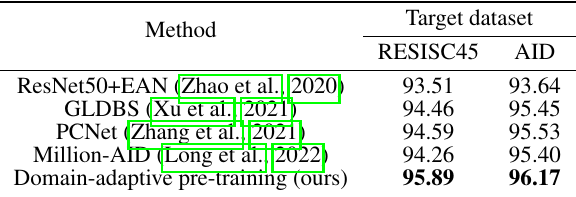
Table 10. Comparison with the state-of-the-art